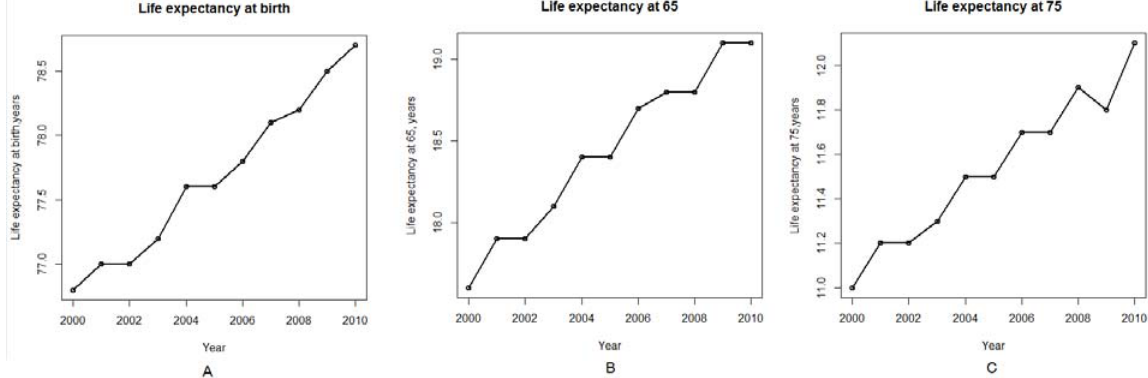
Figure 1. Life expectancy by age in the United States in the first decade of the twenty first century. ( A ) Life expectancy at birth. ( B ) Life expectancy at age 65. ( C ) Life expectancy at age 75. Data is provided by National Center for Health Statistics. Health, United States,